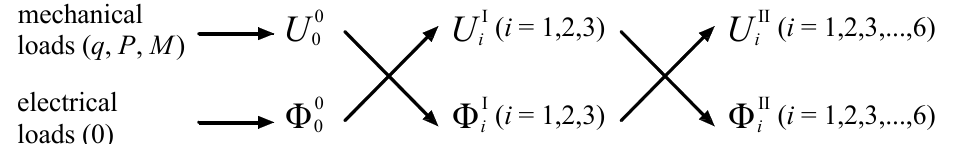
Figure 2. Relationship between the applied loads and the each order perturbation expressions.